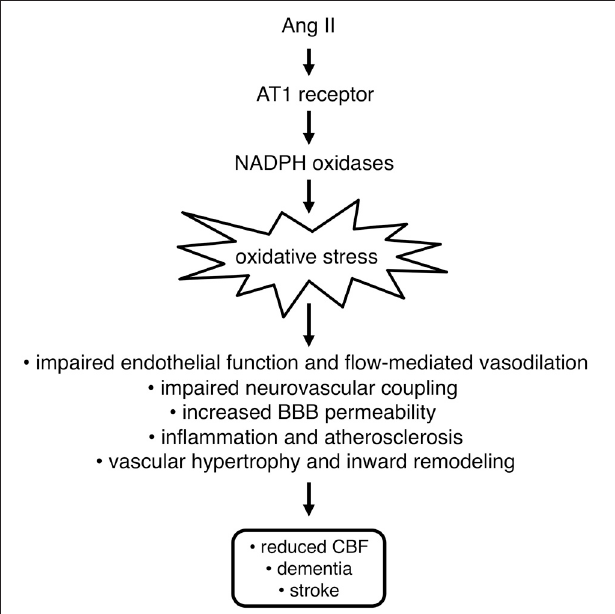
FIGURE 2 | Angiotensin II (Ang II) promotes oxidative stress in the vasculature via stimulation of AT1 receptors and subsequent activation of NADPH oxidases. Oxidative stress contributes to blood-brain barrier (BBB) dysfunction, impairment of vasodilation and neurovascular coupling, and promotes inward vascular remodeling and inflammation. Overall, these effects contribute to reductions in cerebral blood flow, which can lead to dementia and increased susceptibility for stroke and lessen recovery following stroke or other forms of brain